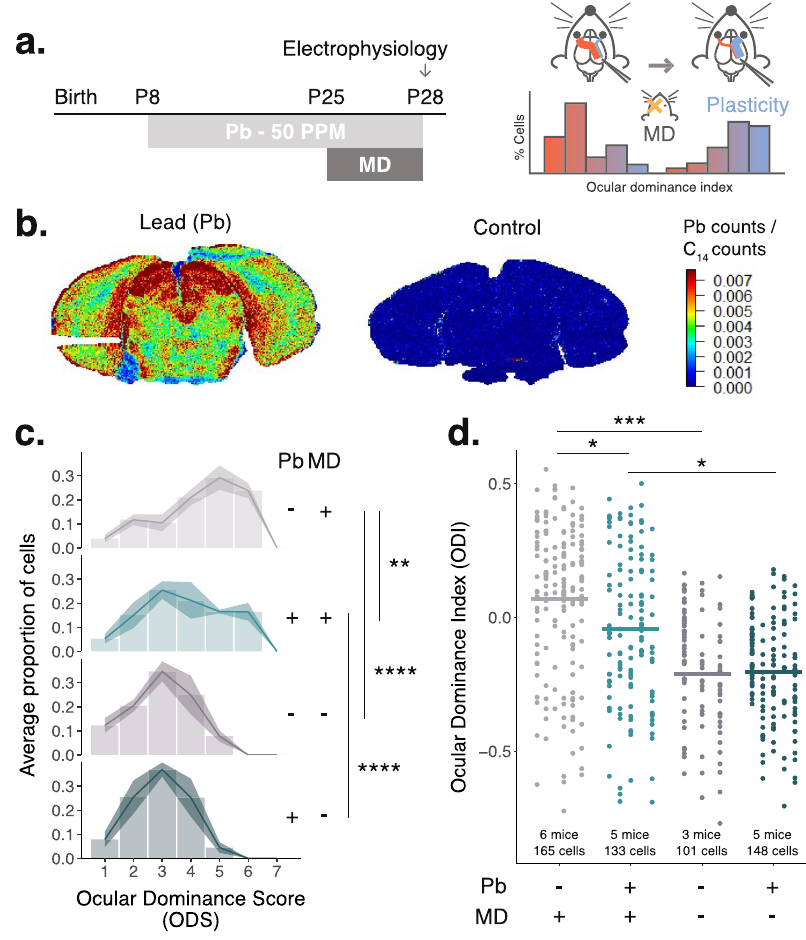
Figure 3. Lead (Pb) suppresses critical period experience-dependent plasticity. ( a ) Mice were administered 50 parts per million (PPM) Pb in drinking water or water alone (control) from P8 through in vivo extracellular recordings to assess ocular dominance plasticity at P27-P29 (avg P28) ( b ) Laser ablation-based elemental mapping revealed dramatic Pb accumulation in visual regions including cortical layers of V1 and superior colliculus [Pb N = 1, control N = 1, both no monocular deprivation (MD)]. ( c ) After 3 days of MD beginning at P24-P26 (avg P25) neurons from control mice (light grey color, 6 mice, 165 cells) exhibited plasticity as quantified at the neuron-level by a shift in their responsivity from the previously deprived eye (contralateral to recording hemisphere) to the nondeprived eye, observable as a right shift in the ocular dominance score (ODS) as compared to control animals who did not receive MD (dark grey color, 3 mice, 101 cells; χ 2 test of ODS distribution: χ 2 = 61.3, P = 6.6 × 10 − 12 ). In contrast, V1 neurons from animals who underwent MD and were administered Pb (light teal color, 5 mice, 135 cells) did not exhibit a full ODS shift (Pb MD versus control MD: χ 2 test of ODS distribution: χ 2 = 17.1, P = 4 × 10 − 4 ), though some residual plasticity remained (Pb MD versus Pb no MD [dark teal color, 5 mice, 148 cells]: χ 2 = 42.8, P = 4.1 × 1 0 − 8 ). ( d ) We carried out an animal-level analysis using a hierarchical linear modeling approach that takes into account within-animal variation (on average, 28.8 neurons were recorded from each mouse) wherein group (Pb or control) and experience (MD or no MD) were assigned as fixed effects and animal was assigned as a random effect to account for repeated neural measurements within each animal. The neuron level ocular dominance index (ODI) was assiged as the continuous outcome variable. After correcting for multiple comparisons using the Holm method, we confirmed plasticity was present in control mice who received MD (light grey color) as quantified by an elevated ODI compared to control animals who did not receive MD (dark grey color) ( β = 0.28, P adj = 0.0002). Mice administered Pb showed significantly reduced plasticity as quantified by a reduction in ODI (Pb MD (light teal color) versus control MD (light grey color): β = − 0.11, P = 0.04), but retained some plasticity relative to no MD animals (Pb MD (light teal color) versus Pb adj no MD (dark teal color): β = 0.16, P adj = 0.012). Horizontal bars indicate the least squares mean. **** P < 0.0001, *** P ≥ 0.0001 and < 0.001, ** P ≥ 0.001 and < 0.01, * P ≥ 0.01 and <